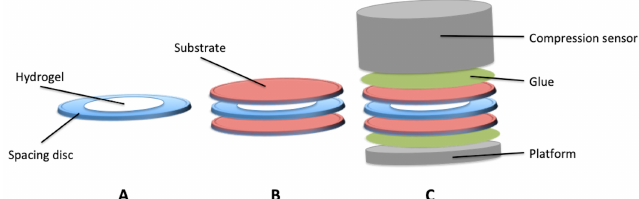
Figure 1. Schematic of the sample preparation for adhesion force measurements. ( A , B ) represent the sample preparation with spacing disc well filed with the hydrogel ( A ) and its adhesion onto the desired substrate ( B ). ( C ) Represents the setting of the sample into the TAHDplus measuring